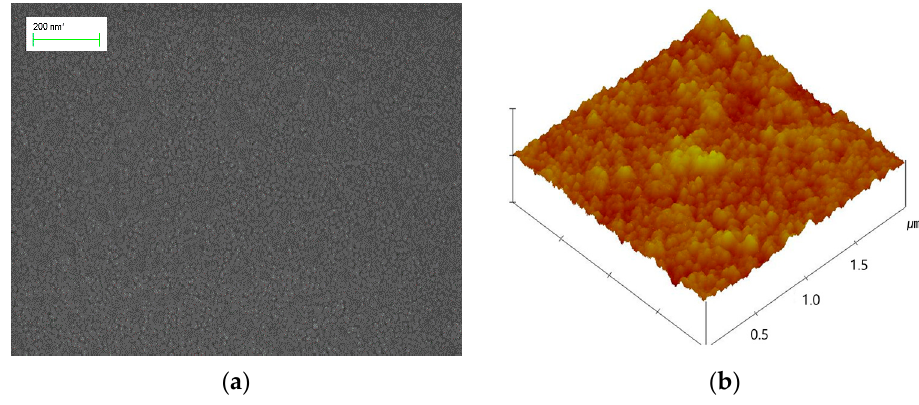
Figure 2. ( a ) High-resolution field emission scanning electron microscopy (HR FE-SEM) and ( b )